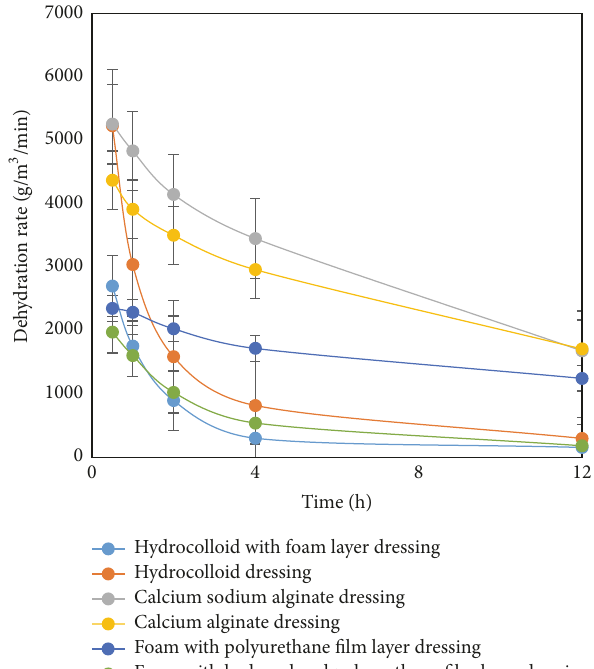
Figure 3: Dehydration properties.